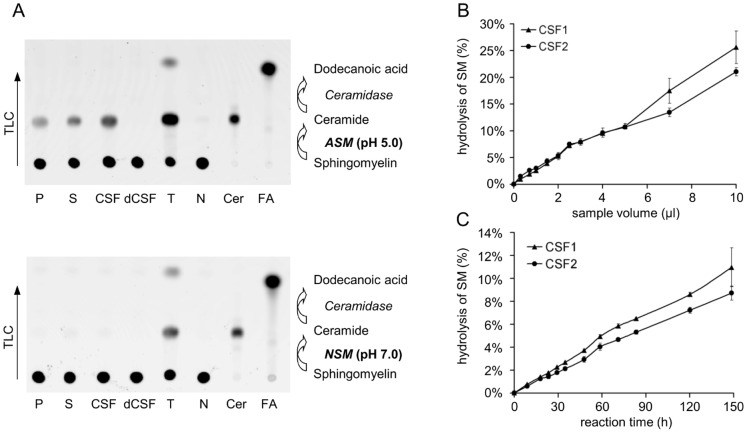
Detection of S-ASM activity in CSF and linear relationship between product, sample volume and time.A: Separation of reaction mixtures by thin layer chromatography with the fluorescent substrate BODIPY-C12-SM at the application site and the migrated fluorescent product, BODIPY-C12-ceramide, for samples of plasma (P), serum (S), tissue lysate (T), CSF in addition to heat-denatured CSF (dCSF) and water (N) as the negative control as well as ceramide (Cer) and dodecanoic acid (FA) as reference. B: Linear correlation between the amount of generated product and the applied volume. C: Linear correlation between the amount of generated product and the reaction time.